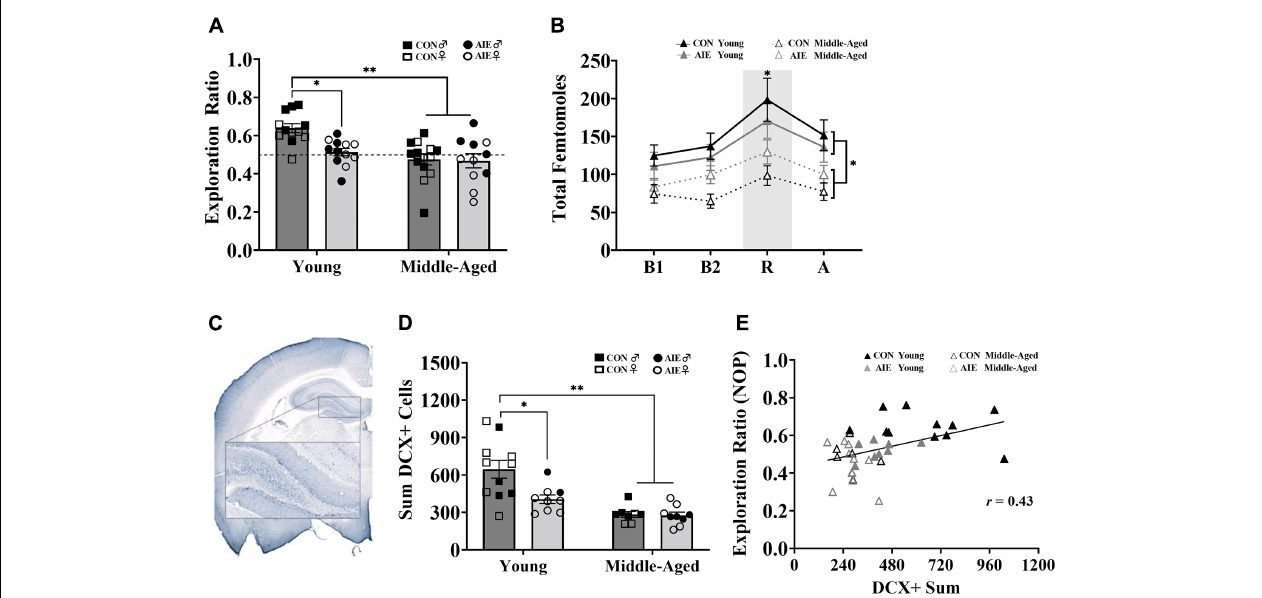
FIGURE 4 | AIE and age similarly affect retention of object placement and neurogenesis in the dentate gyrus. (A) Young AIE exposed rats (Male = 6; Female = 6) had lower exploration ratios ( ∗ p < 0.05) than young control rats (Male = 6; Female = 6). Overall, middle-aged rats (AIE: Male = 5; Female = 6; CON: Male = 8; Female = 6) had lower exploration ratios than young rats ( ∗∗ p < 0.001). There were no effects of sex on NOP performance ( p = 0.15). An exploration ratio of 0.5 (dashed line) indicates equal amounts of time spent with the object in the novel location and the object in the familiar locations. (B) Middle-aged rats, regardless of sex, had suppressed total femtomole efflux of ACh during baseline [B1, B2; ( ∗ p < 0.001)], NOP retention (R) testing ( ∗ p = 0.006) and after (A) testing ( ∗ p = 0.05). (C) Image of DCX+ cells in the granule cell layer of the dentate gyrus (AP: –3.24 mm). Cells were quantified in one hemisphere on every 6th 40 µ m section of the dorsal HPC. (D) Young AIE exposed rats had fewer DCX+ cells in the granule cell layer of the dentate gyrus compared to age-matched controls ( ∗ p < 0.05). Overall, middle-aged rats had fewer DCX+ cells in the dentate gyrus compared to young water control rats ( ∗∗ p < 0.001). Due to the quality of tissue, some samples were not included in cell quantification and sex differences were not able to be determined. For final DCX+ counts: Young control males ( n = 4), young control females ( n = 7), young AIE males ( n = 2), young AIE females ( n = 7), middle-aged control males ( n = 5), middle-aged control females ( n = 3), middle-aged AIE males ( n = 4), middle-aged AIE females ( n = 5). (E) Levels of neurogenesis in the dentate gyrus of the dorsal HPC correlate with performance on a pattern separation task. Exploration ratios on the NOP task positively correlated with sum values of DCX+ cells ( r = 0.43, p =